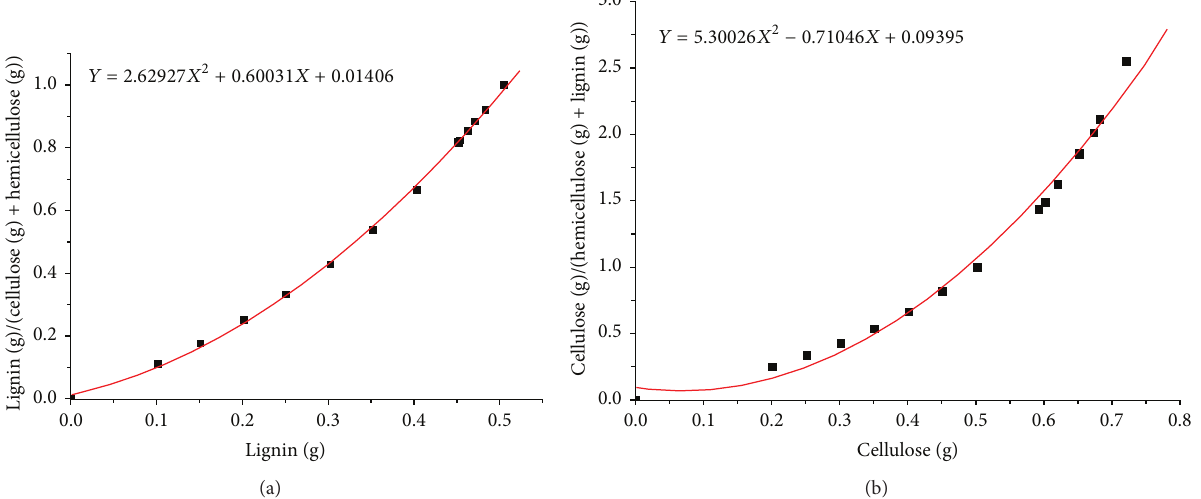
Figure 4: Two predictive models for the indirect determination of hemicellulose in ternary mixtures of cellulose-hemicellulose-lignin.